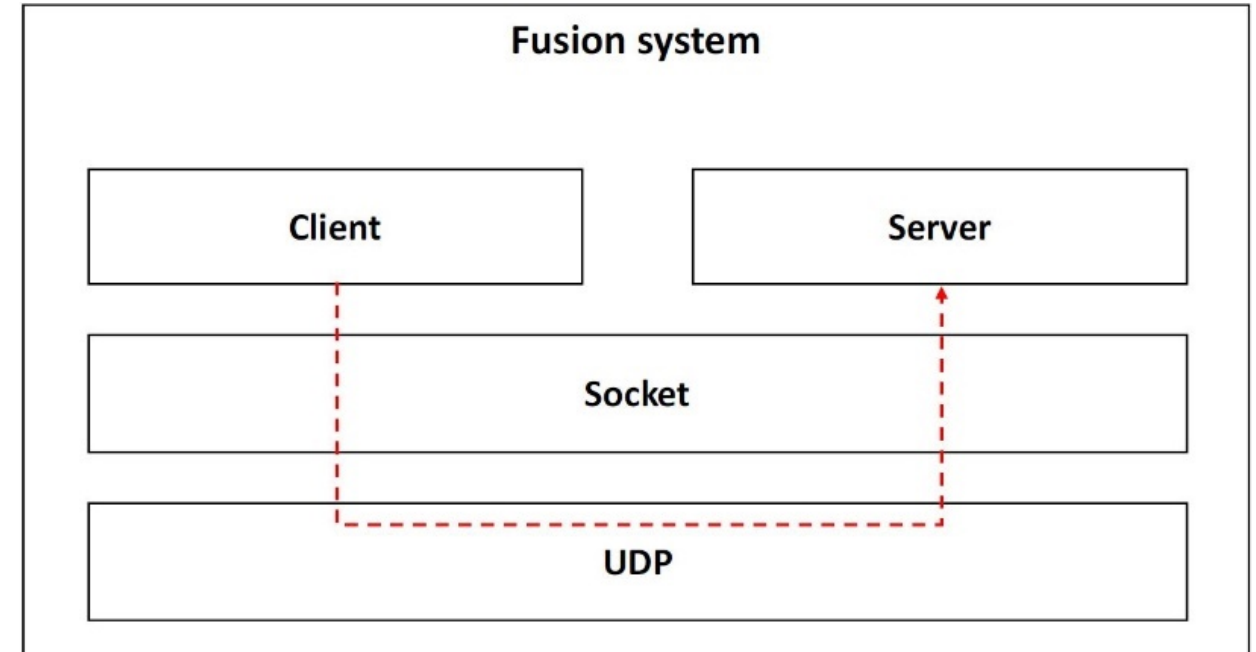
Figure 4. IPC in the fusion system.